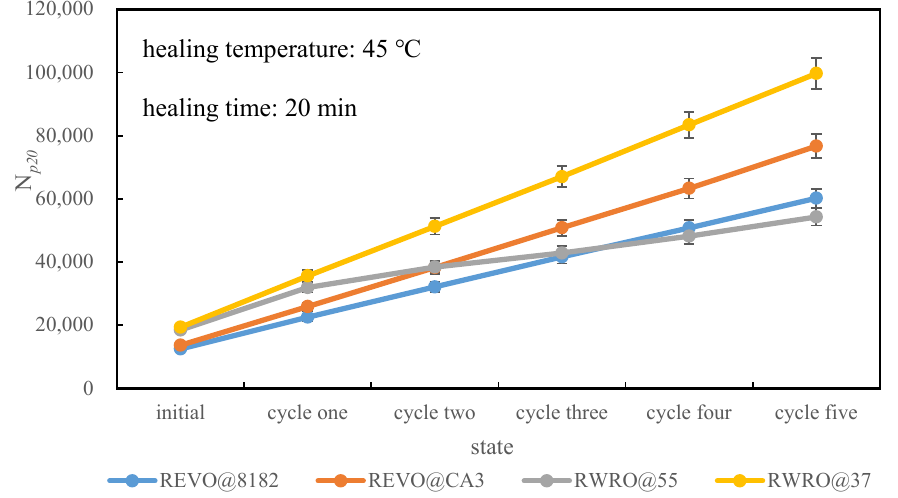
Figure 15. Fatigue life considering self ‐ heling compensation.